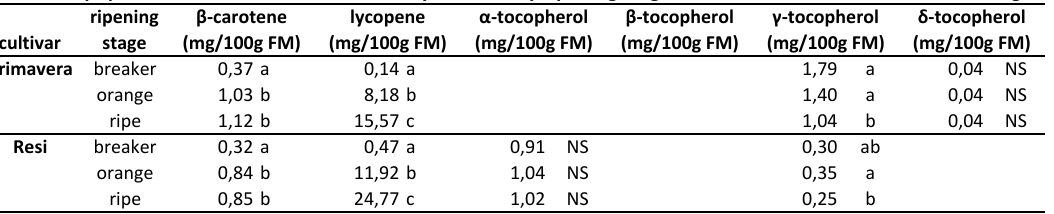
Table S4: Lipophilic antioxidants are differentially affected by ripening stages in the two cocktail tomato cultivars grown in 2015. cultivar